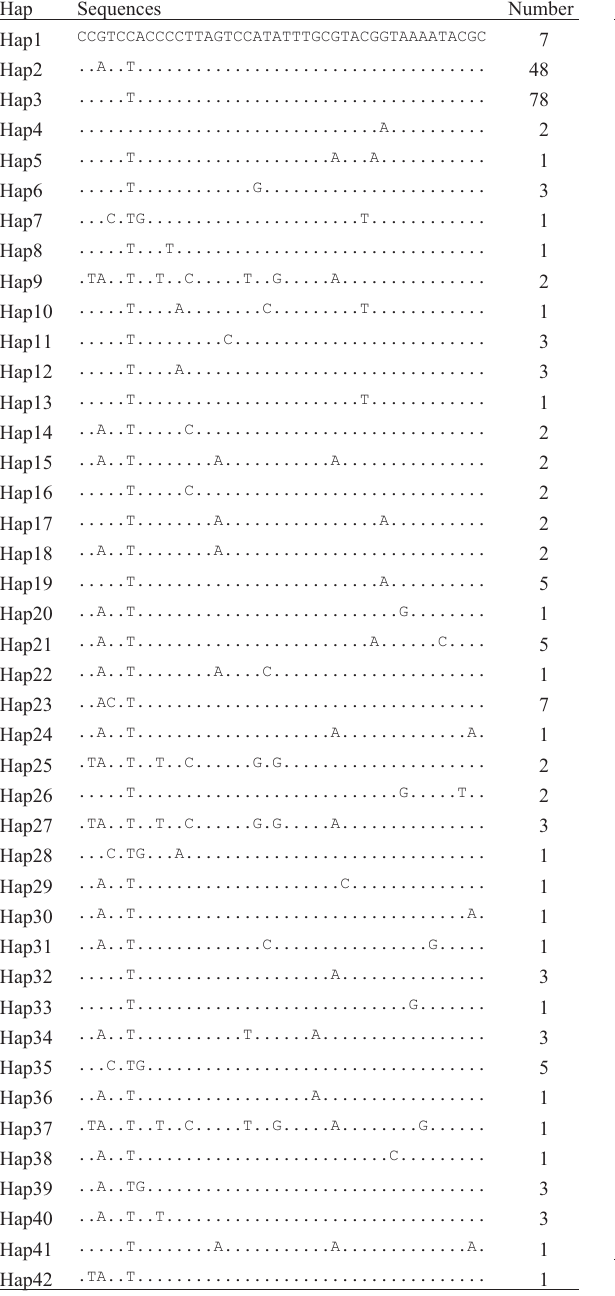
match distributions (Figure 2), the low raggedness index, the star-like shape of the phylogenetic tree, and the ample distribution of the most common haplotypes. The ragged- ness index and SSD, and expansion parameters theta and tau estimated under the expansion model are presented in